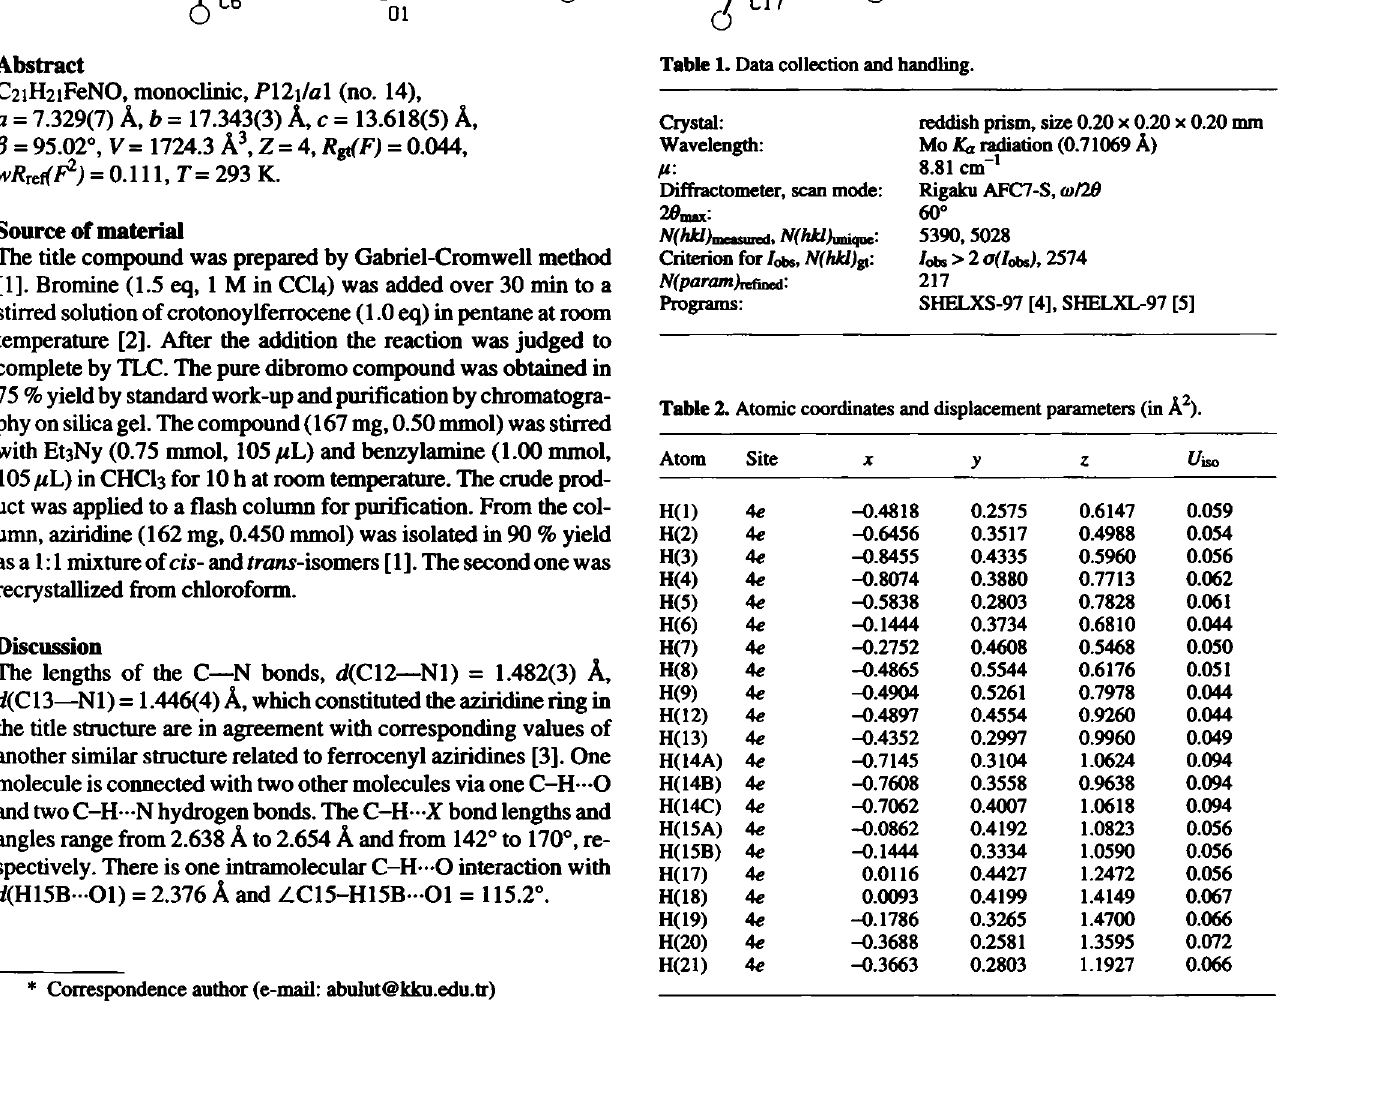
Table 1. Data collection and handling.